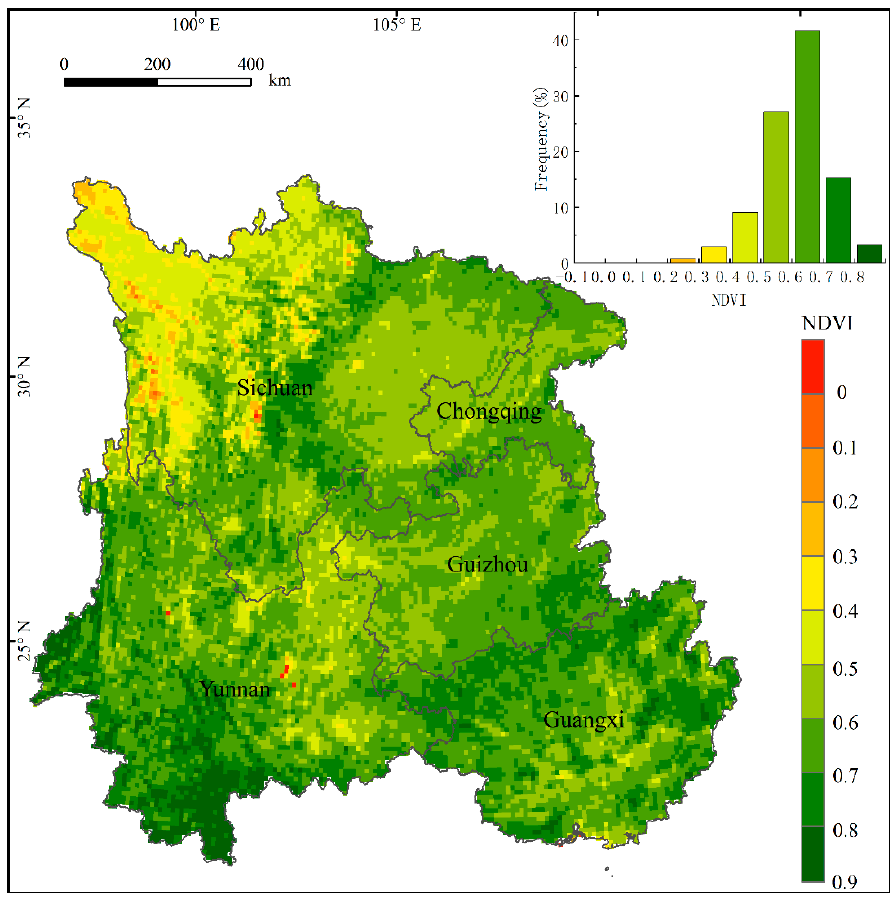
Figure 3. Spatial pattern of multi-year mean NDVI over Southwest China from 1982 to 2015.